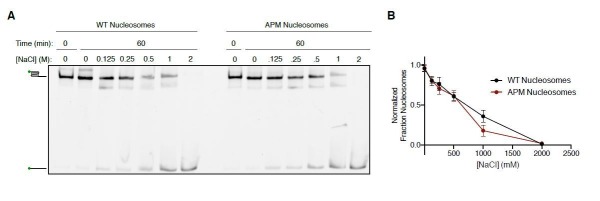
Salt-based nucleosome dissociation of WT and APM nucleosomes.A. 15 nM 0/60 cy3-DNA labeled Nucleosomes were incubated in 25 mM HEPES pH 7.5 and varing concentrations of NaCl at 20ºC and resolved on a 6% native polyacrylamide gel. The gels were scanned for the cy3 label (green symbol on nucleosome and DNA cartoons on left of gel). B. Quantification of the fraction of nucleosomes remaining as a function of salt concentration. Fraction nucleosomes was determined by taking the ratio of the signal for the nucleosome bands to the signal for all the bands in each lane. Values were normalized to unincubated controls. The points and error bars plotted reflect the mean and standard error for n=3 experiments.